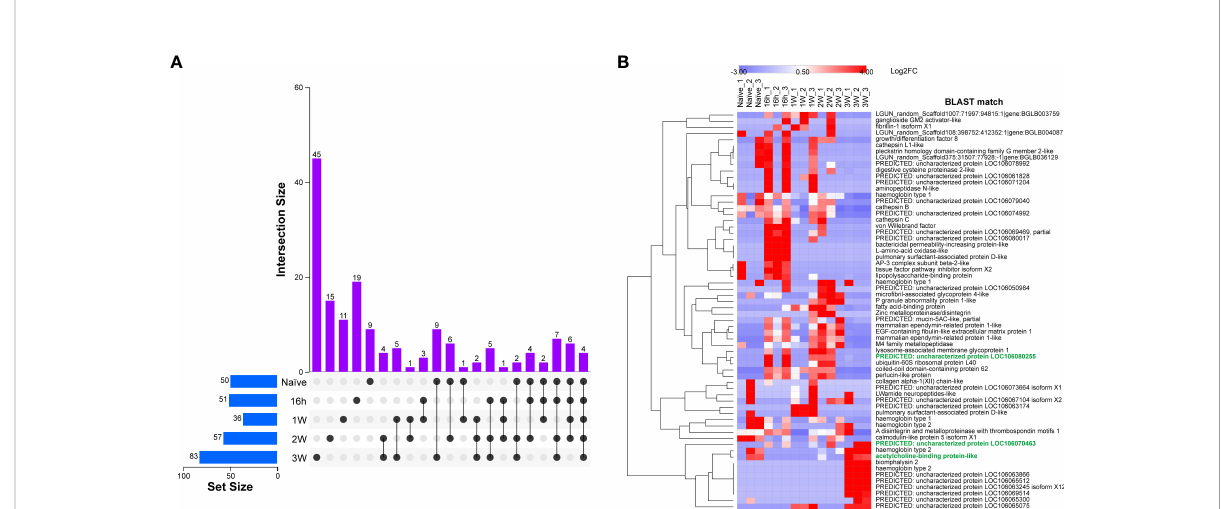
FIGURE 2 Identi fi cation and quanti fi cation of ESPs present with con fi dence from naïve, 16h-PME, 1W-PME, 2W-PME and 3W-PME B glabrata SCW. (A) An UpSet plot displaying con fi dence ESP distribution across SCW treatments; (B) Heatmap displaying the relative abundance of ESPs identi fi ed from SCW triplicates using a label-free semi-quantitative proteomic method. Attractant candidates are denoted with green